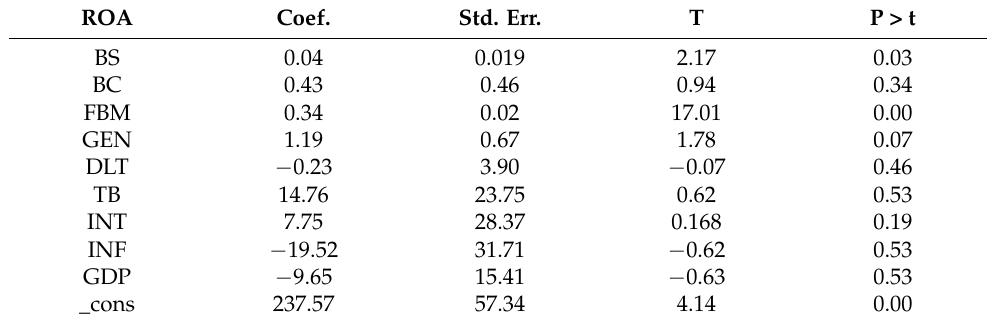
Table 6. Random effect panel model.